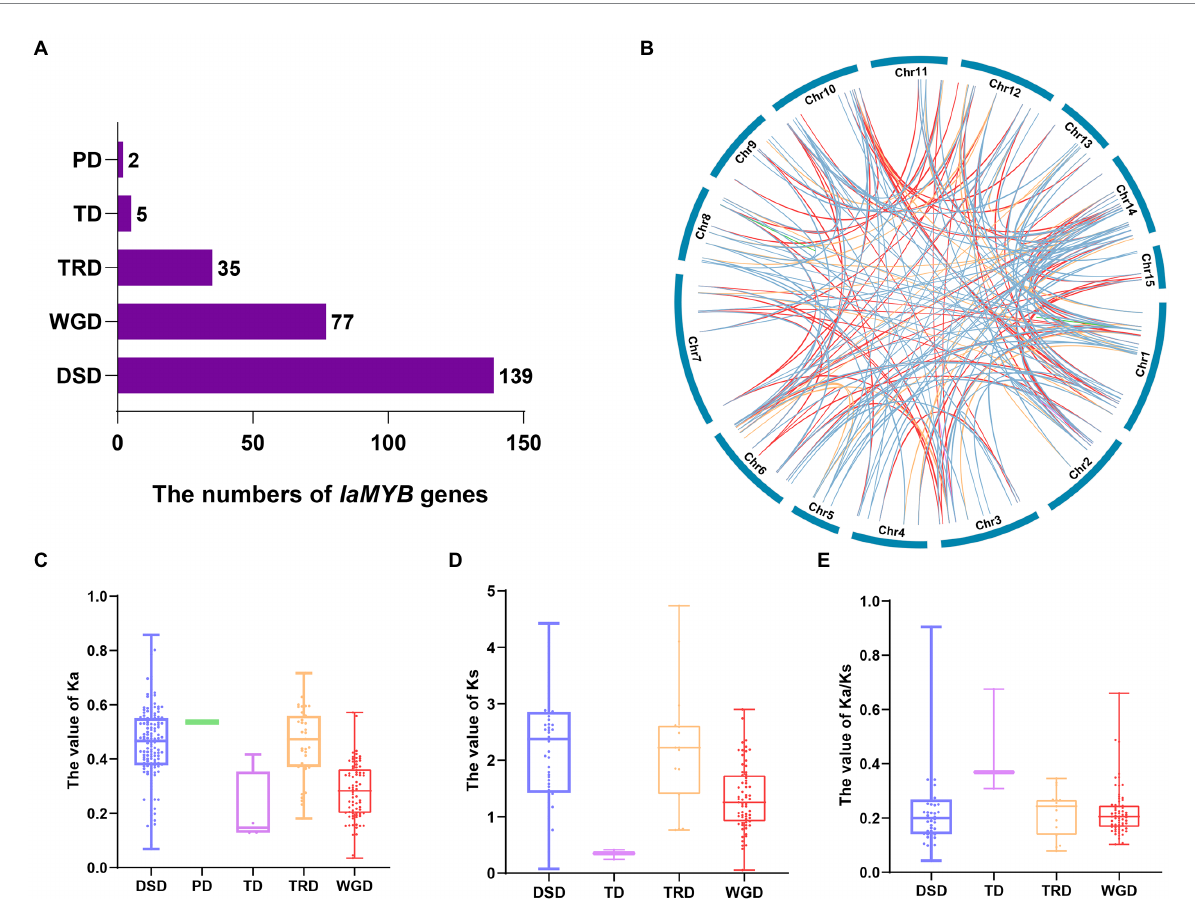
FIGURE 6 Gene duplication events of IaMYB genes. (A) The number distribution of the duplicated genes in the five duplication events. (B) Chromosome distribution of the duplicated genes in each event. The blue line, green line, purple line, yellow line, and red line linked with each chromosome show the duplicated genes originated from DSD, PD, TD, TRD, and WGD, respectively. (C–E) The Ka, Ks, and Ka/Ks distribution of the duplicated genes in the five duplication